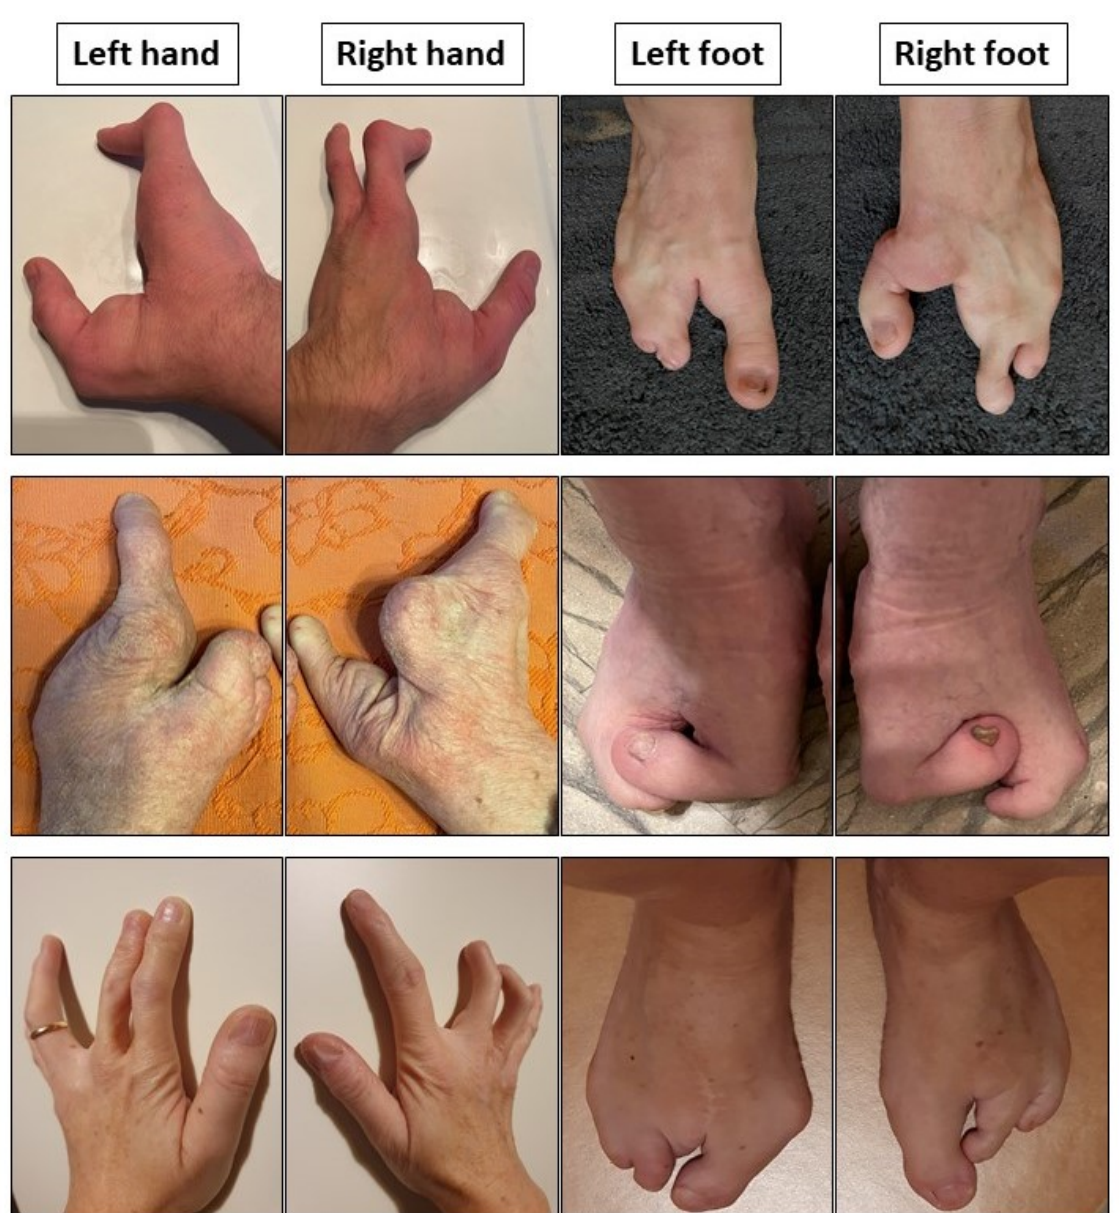
Figure 1. Phenotypic tracts of ectrodactily-ectodermal dysplasia clefting (EEC) syndrome. Ectrodac- tily and sindactily are visible in the hands and feet of three EEC patients. In adult tissues, p63 is highly expressed in the basal layer of the epidermal